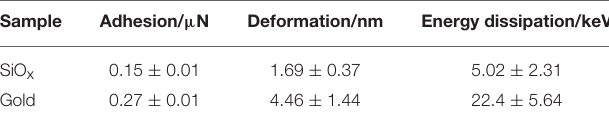
TABLE 1 | Tip-sample contact and mechanical